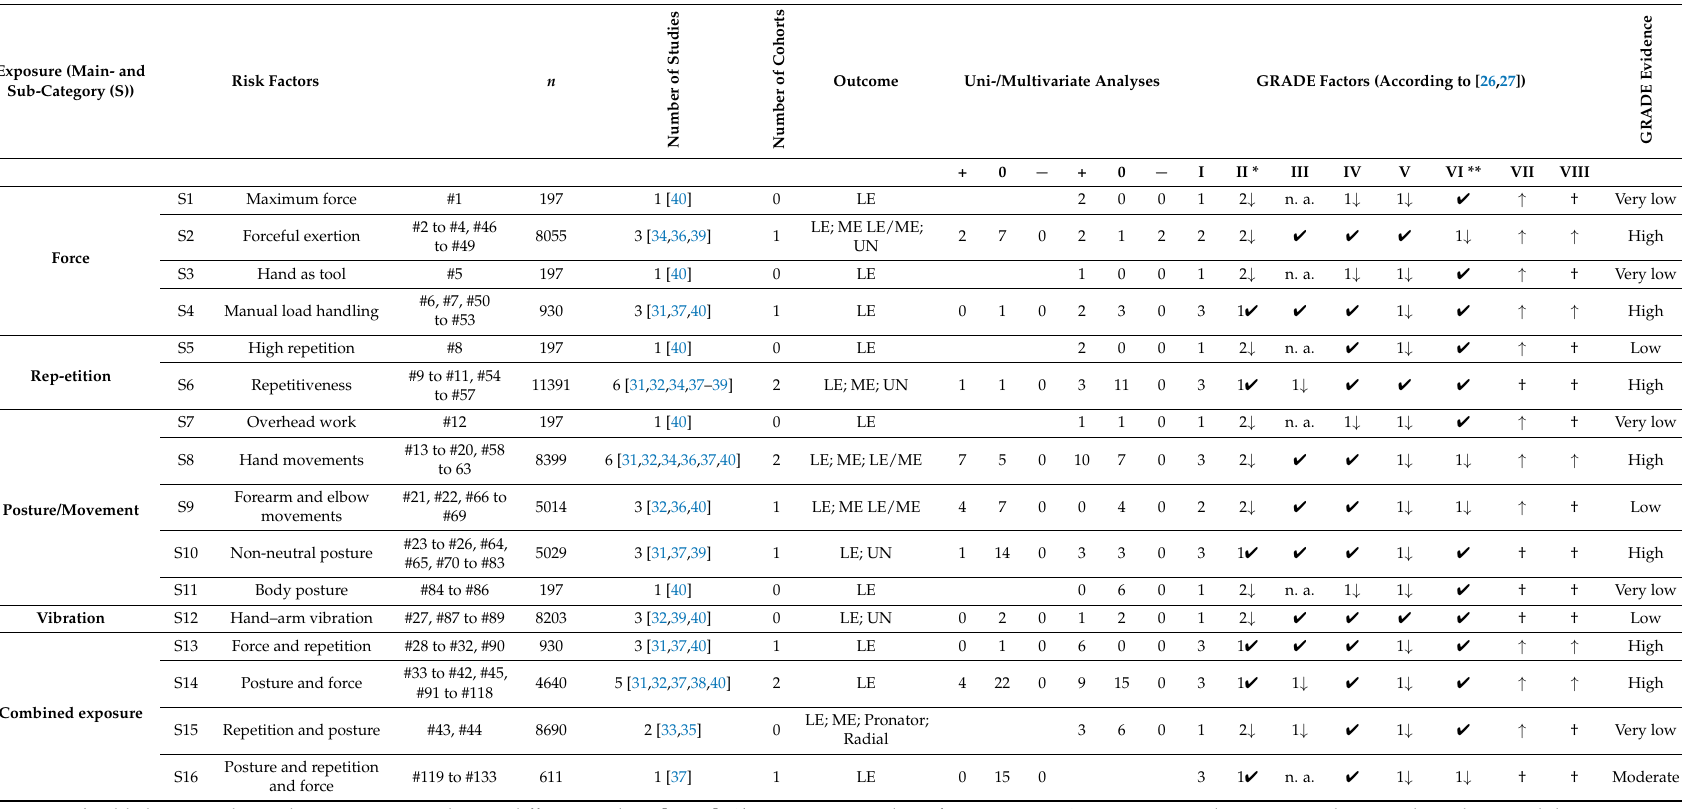
Legend: table layout, column descriptions according to different authors [26,27]; Shortcuts: n = number of participants; Outcome: UN = ulnar neuropathy; LE = lateral epicondylitis; ME = medial epicondylitis, LE/ME = lateral and/or medial epicondylitis, Radial = Radial tunnel syndrome, Pronator = Pronator teres syndrome; Uni-/Multivariate Analyses: type of analysis univariate/multivariate; + = number of significant effects with a positive value; 0 = number of non-significant effects; − = number of significant effects with a negative value; GRADE factors: I = phase of investigation; II = study limitations; III = inconsistency; IV = indirectness; V = imprecision; VI = publication bias; VII = moderate/large effect size; VIII = dose effect; Symbols: ↓ significant downgrading; (cid:52) no serious limitations/no downgrading); n. a. = not applicable; ↑ significant upgrading; † no upgrading; * Bias assessment according to [28,29]; ** overall quality of evidence was downgraded by phase of investigation: no